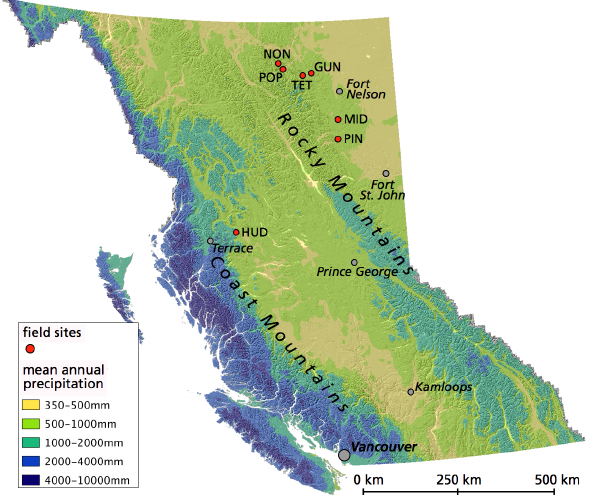
Figure 1. Overview of the field sites on a precipitation map of British Columbia. The field sites span a latitudinal range from 54 ◦ 45 (cid:48) to 59 ◦ N and are located within or close to the Coast Moun- tains and Rocky Mountains. These two main mountain ranges cause large gradients in precipitation and continentality within short dis- tance (precipitation data from Wang et al.,